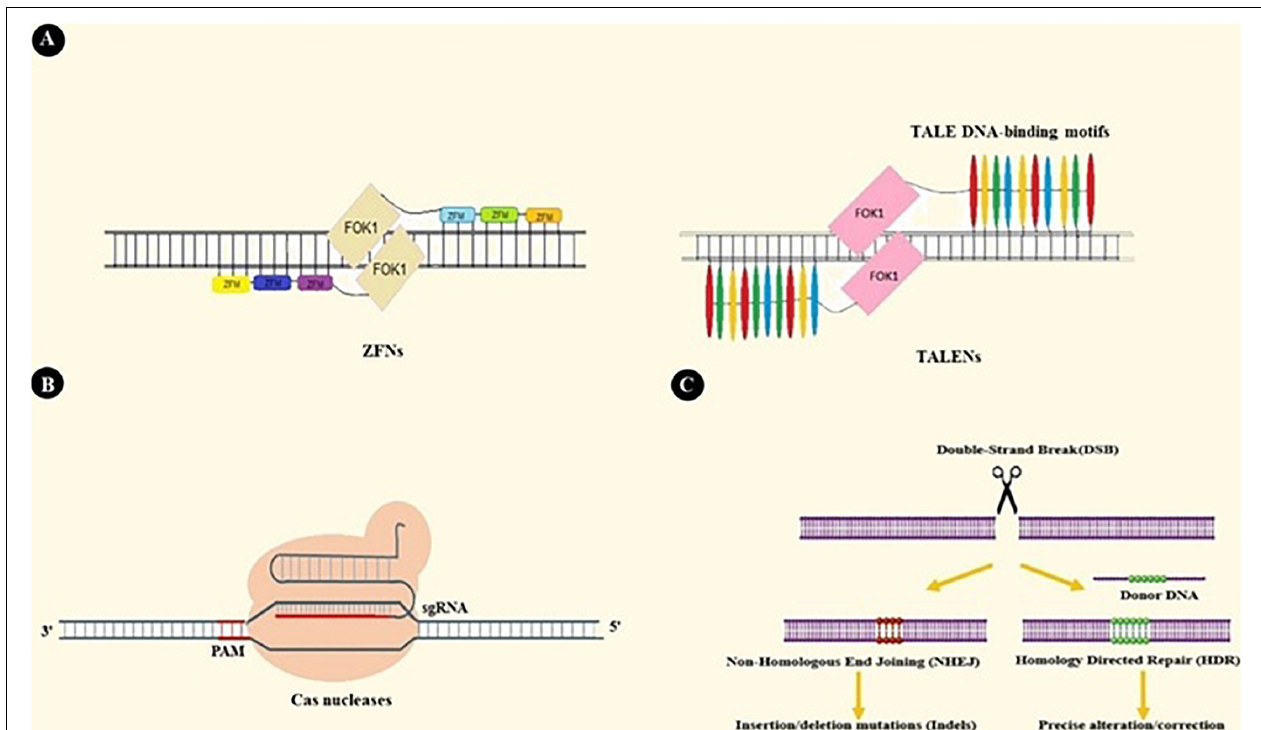
FIGURE 2 | ZFNs, TALENs, and CRISPR-based genome editing. (A) ZFNs and TALENs are nucleases that operate based on protein-DNA interactions. Assembling Zinc Finger Motifs (ZFMs) and TALEs into larger complexes increases specificity. (B) CRISPR/Cas9 binds to DNA under the guidance of single guide RNA (sgRNA). sgRNA is a chimeric RNA constructed by fusing crRNA and tracrRNA to simplify the guidance system. As a result, Cas9-sgRNA is the most extensively used system in CRISPR based applications (23). For DNA recognition, many CRISPR systems also need Protospacer Adjacent Motif sequence (PAM) adjacent to the crRNA target site. PAM sequences are specific to each type of nuclease (e.g., NGG sequence is specific to SpCas) (21, 198). (C) Double-Stranded Breaks (DSBs) created by Cas9 in DNA structure activate two DNA repair pathways: Non-Homologous End Joining (NHEJ) and Homology-Directed Repair pathways (HDR). NHEJ results in random insertions or deletions at the target site, so it involves knocking out genes in CRISPR-based applications. HDR is a precise pathway that repairs target DNA breakage by using a homologous donor DNA. This pathway takes part in techniques that need more precise genome editing, like insertion or deletion of the desired DNA fragment (199,